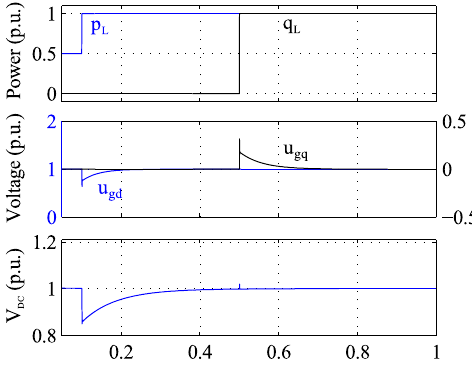
Figure 6. State-space model step